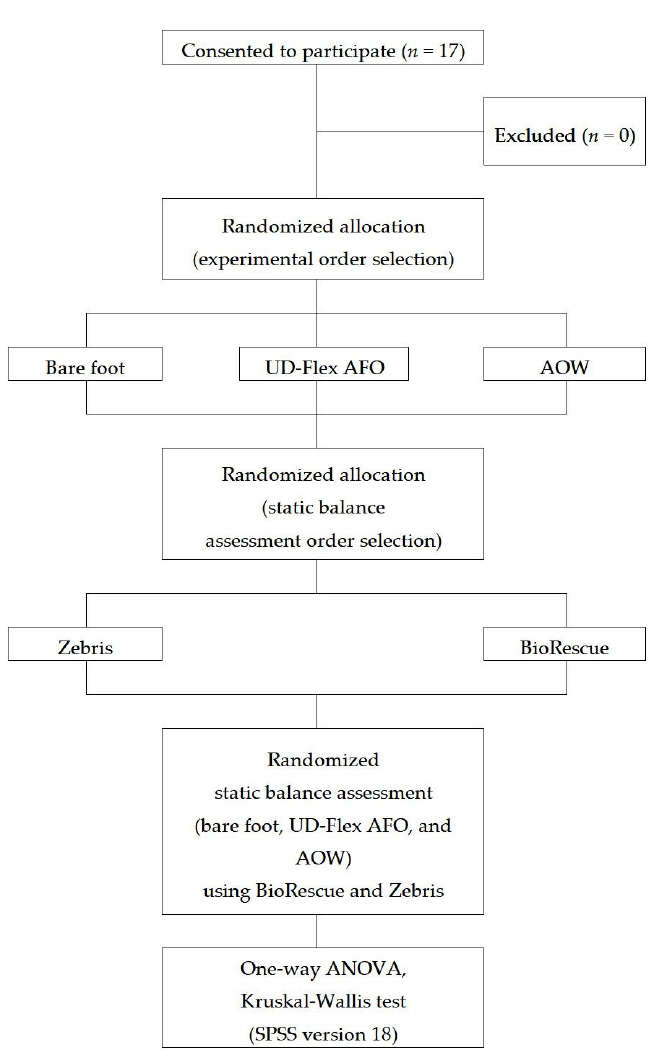
Figure 1. Study flowchart. AFO: ankle–foot orthosis; AOW: ankle–foot orthosis using wire; ANOVA: analysis of variance. SPSS (IBM Corp., Armonk, NY, USA).